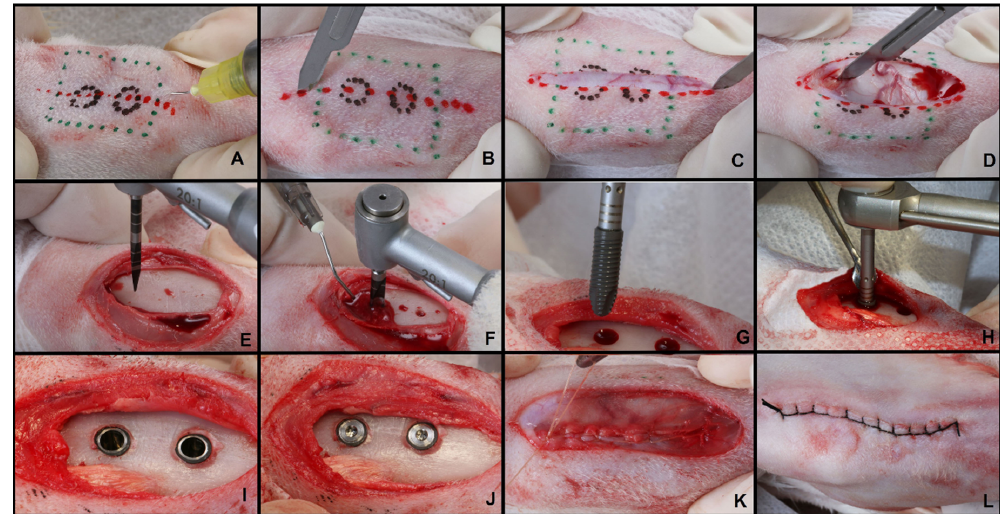
Figure 2. Surgical procedure for installing implants in the tibial metaphysis of rabbits. Schematic drawing to define the tibial metaphysis and local anesthesia ( A ); Incision in layers ( B – D ); Detachment and exposure of the tibia, and perforation according to the manufacturer’s recommendations under abundant sterile saline irrigation ( E , F ); Installation of the implants ( G , H ); Implants and cover screws installed ( I , J ); Internal suture of the muscular fascia with resorbable thread and external suture with non-resorbable thread ( K , L